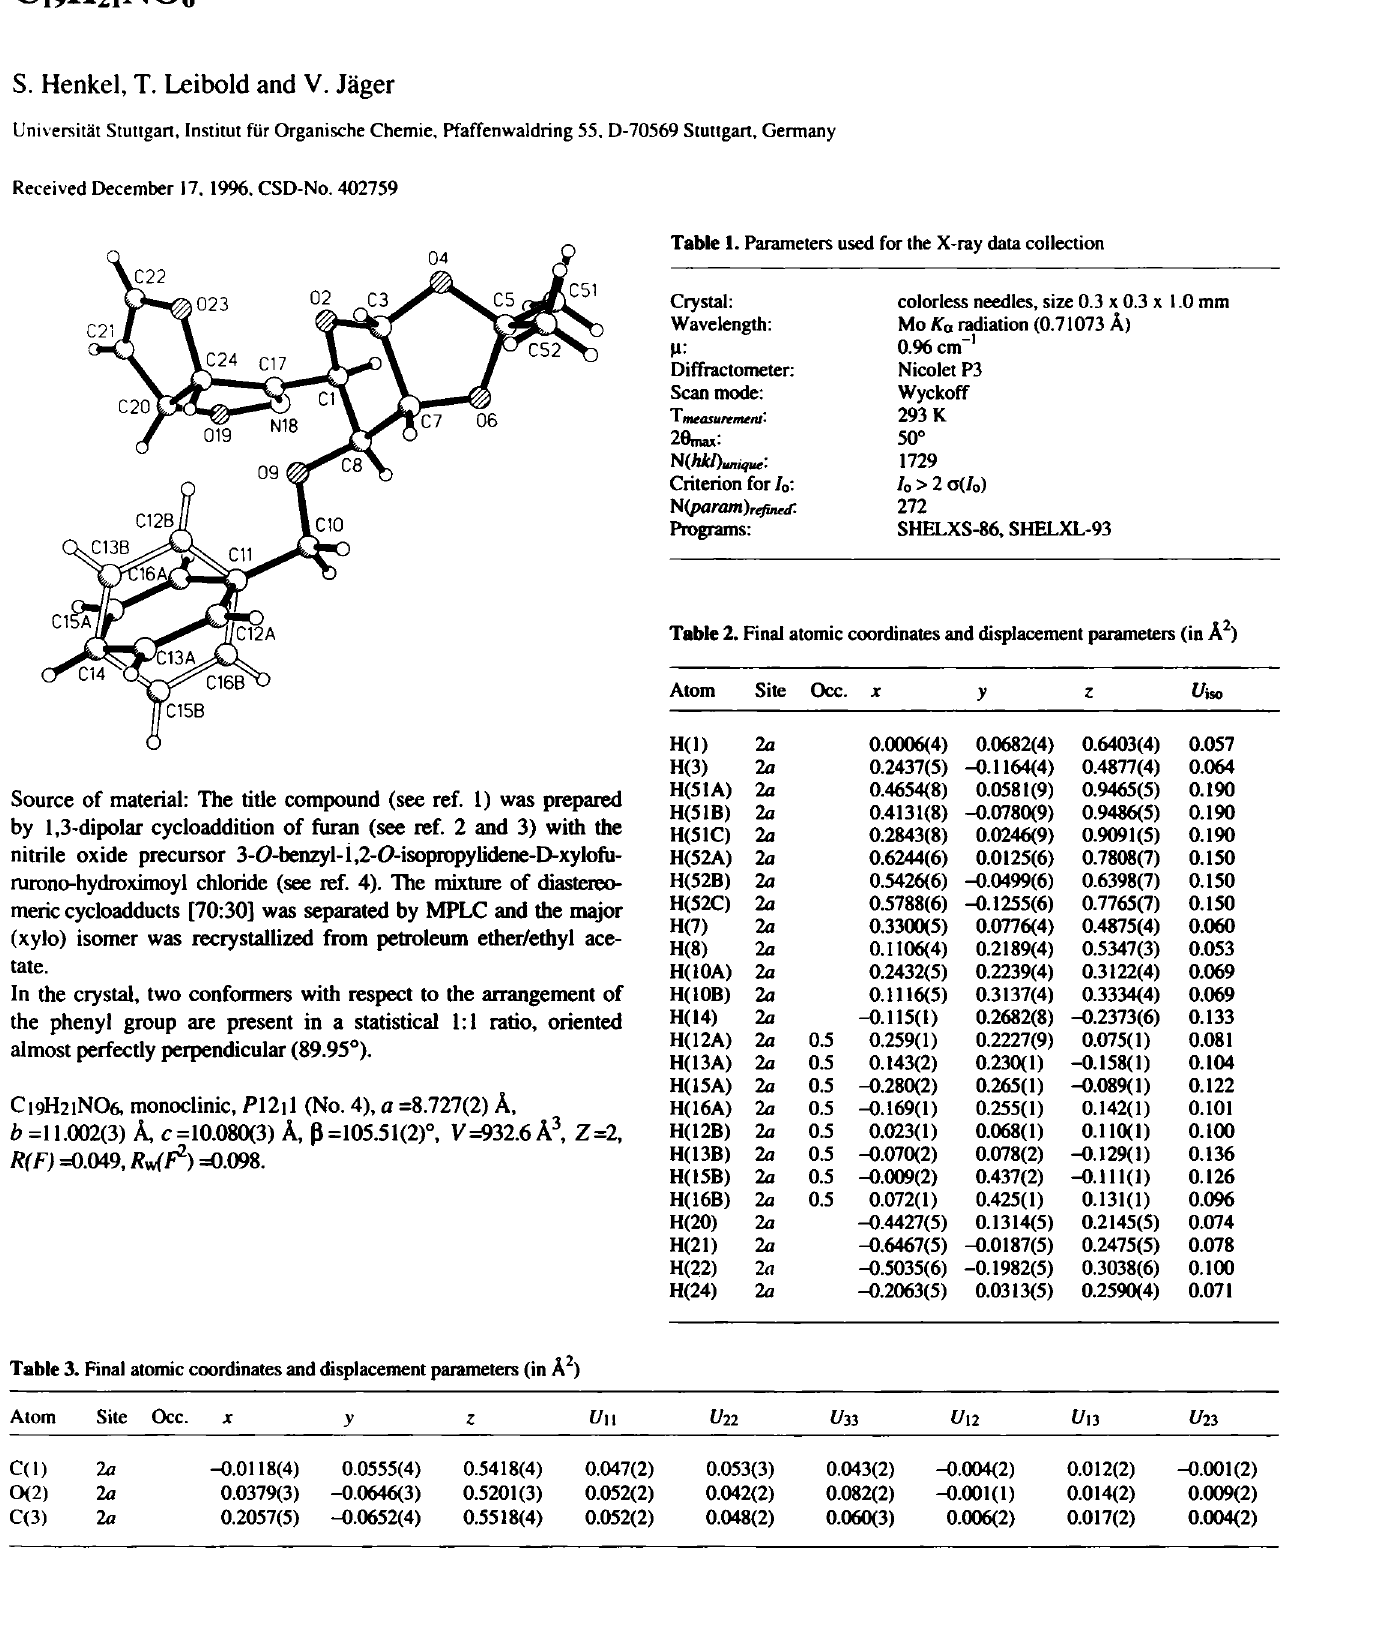
Table 3. Final atomic coordinates and displacement parameters (in Â 2 ) Atom Site